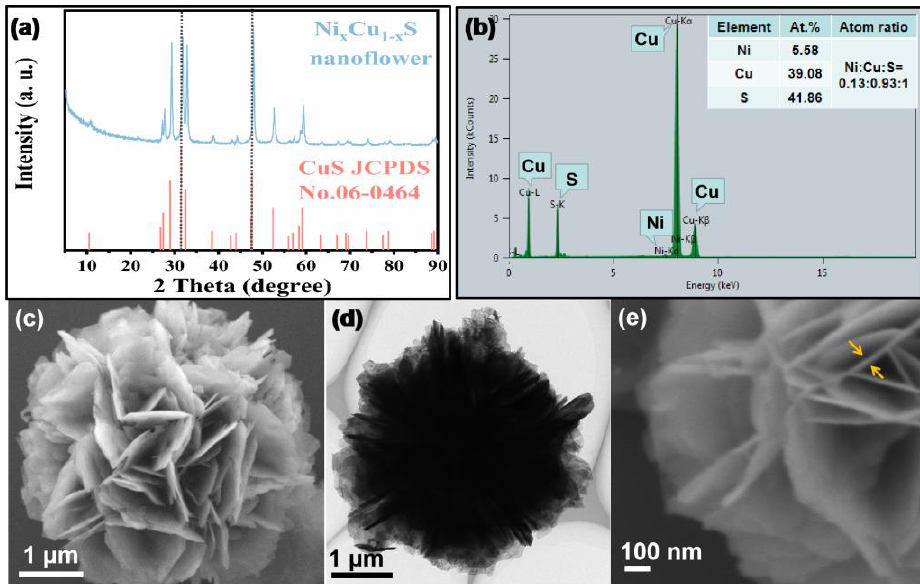
Figure 1. ( a ) The XRD pattern, ( b ) EDS spectrum (the inset shows the atomic percentage), ( c ) low- magnification SEM image, ( d ) low-magnification TEM image and ( e ) high-magnification SEM image of Ni 0.1 Cu 0.9 S nanoflower.